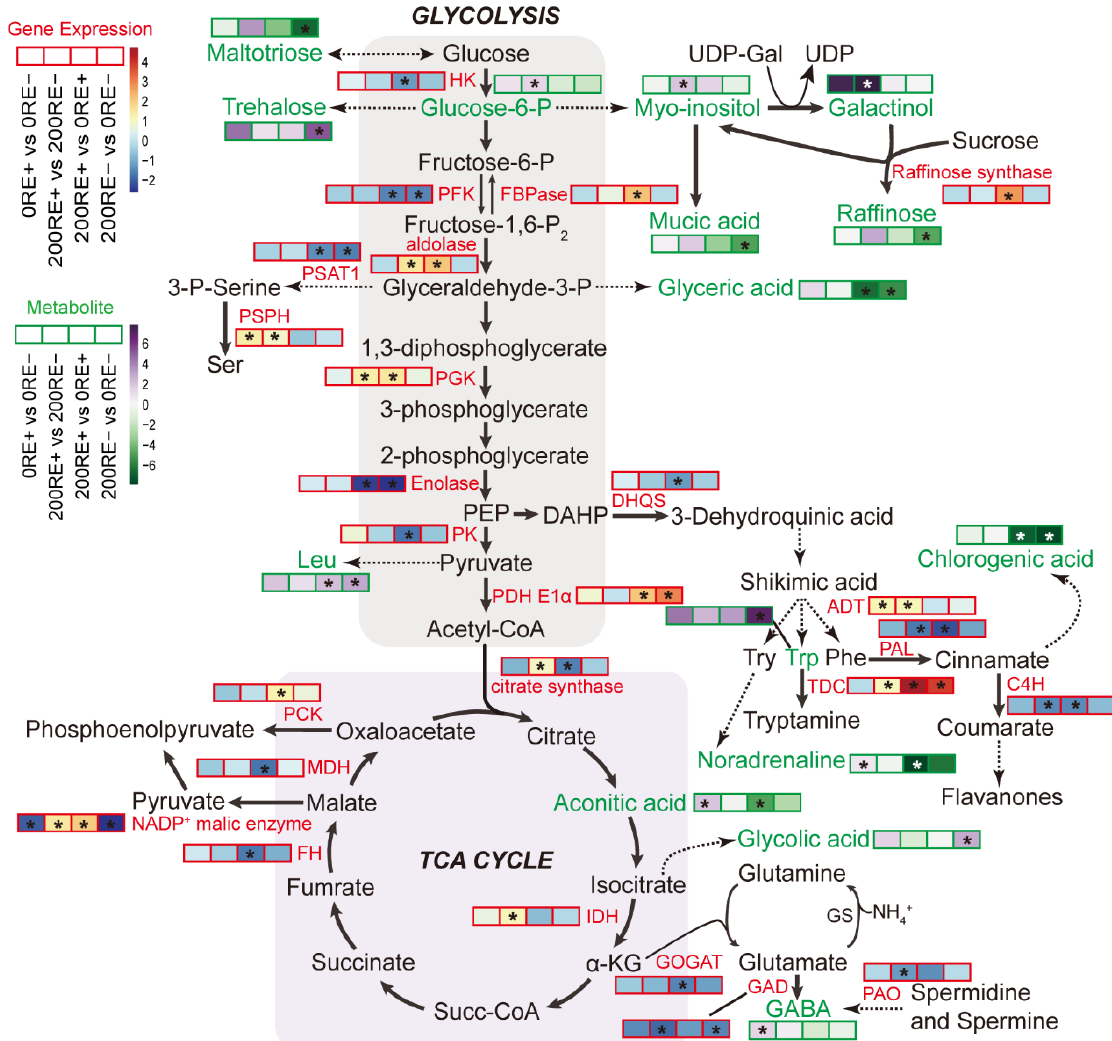
Figure 8. Integration of changes in transcription and metabolite levels mapped to the central metabolic pathways in roots of E+ and E − A. inebrians at 0 and 200 mM NaCl concentrations. Boxes with red and green frames denote the gene expression and metabolites, respectively. The straight arrows represent direct paths, and the dotted arrows represent indirect paths. Asterisks represent statistically significant changes ( p ≤ 0.05).